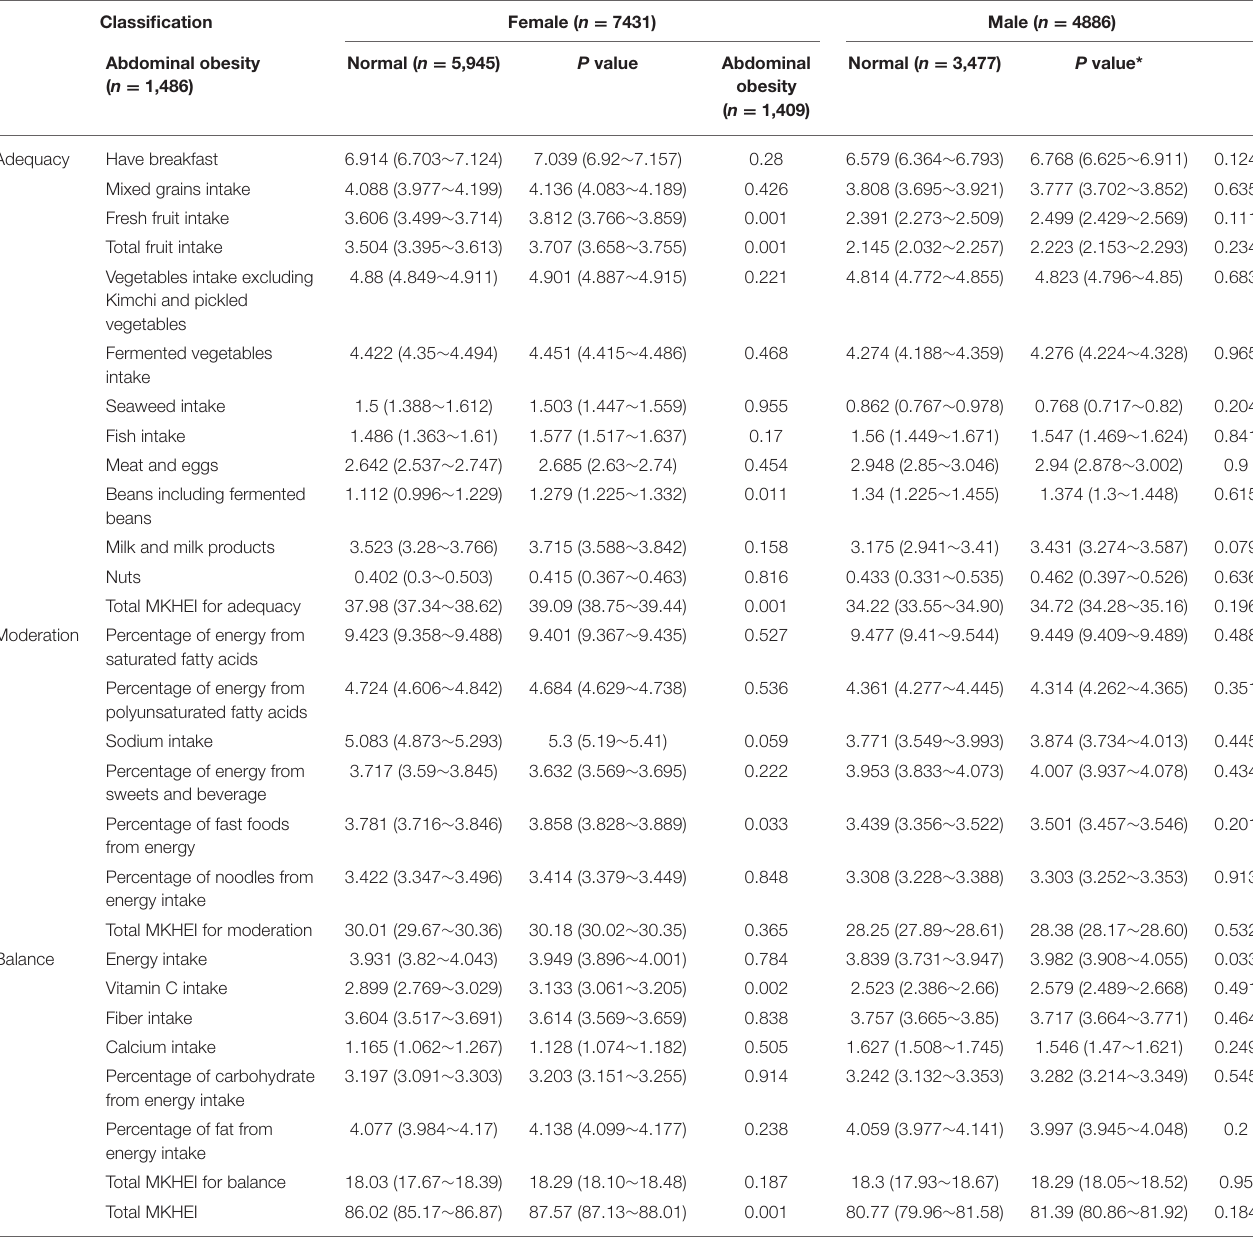
TABLE 4 | Adjusted ¶ means and 95% CI of modified Korean health eating index (MKHEI) scores according to genders and abdominal obesity calculated by waist